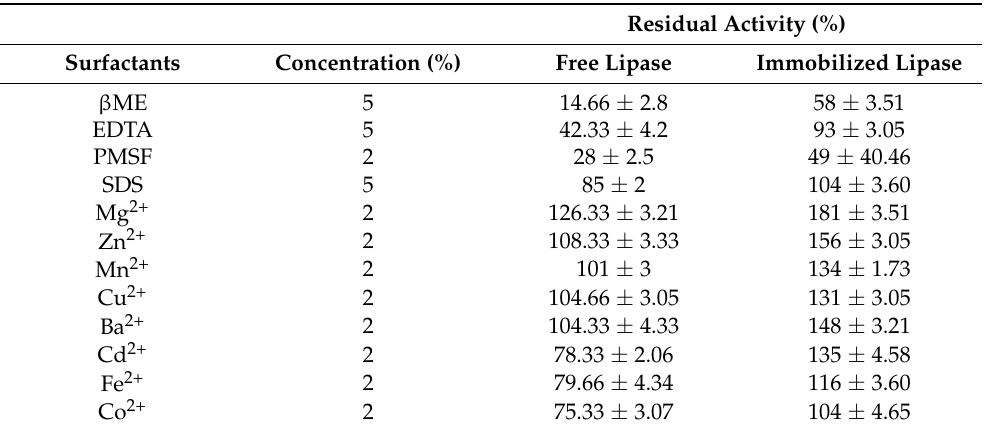
Figure 4. Effect of pH and temperature on B. stearothermophilus activity and stability. Effect of pH on both free and immobilized B. stearothermophilus lipase activity ( A ) and stability ( B ). Stability was analyzed after preincubating the enzymes for 48 h in different buffer solutions at various pH levels ranging from 2 to 13. Temperature effect on enzyme activity ( C ) and stability ( D ) of free and immobilized B. stearothermophilus lipases. To determine temperature stability, enzymes were preincubated at different temperatures for 1 h with activity measured under standard conditions. Data are expressed as the mean ± standard deviation of triplicate measurements. Table 2. Effect of metal ions and other compounds on free and immobilized B. stearothermophilus lipase